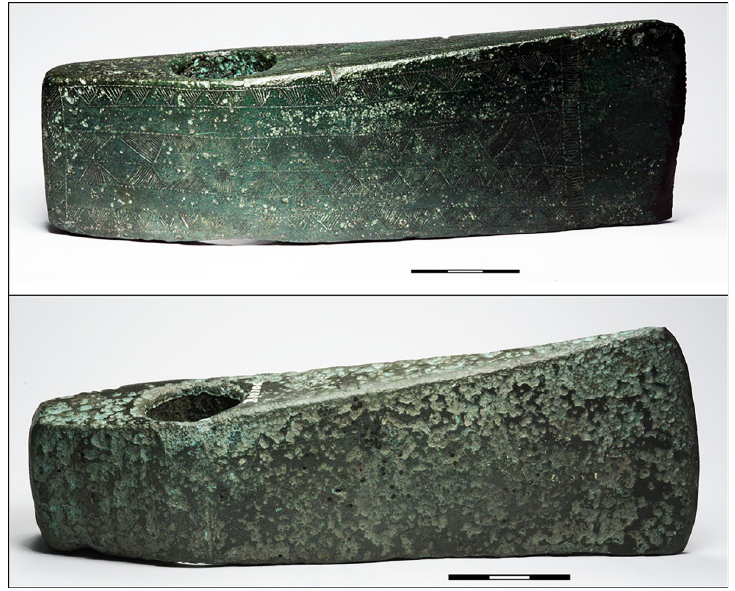
Fig 6. Decorated shaft-hole axes from an unknown find location, NM 541 (top) and Juellinge, Maribo Amt (NM B10106). Photo: Heide W. N ø rgaard, by permission of the National Museum, Copenhagen.